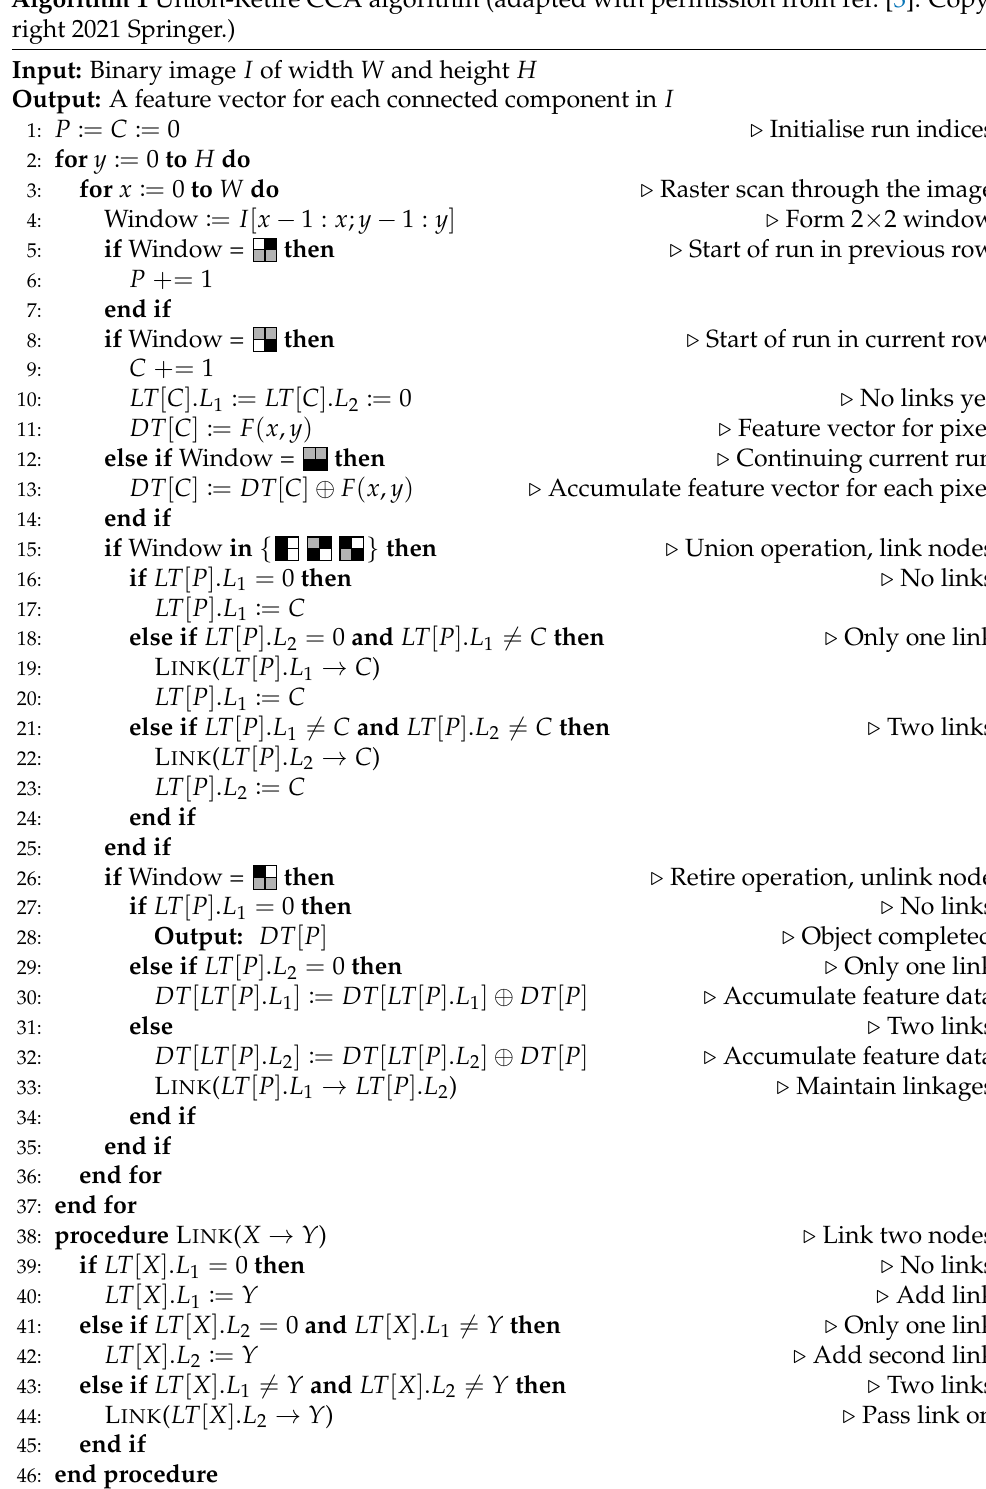
Algorithm 1 Union-Retire CCA algorithm (adapted with permission from ref. [3]. Copy- right 2021